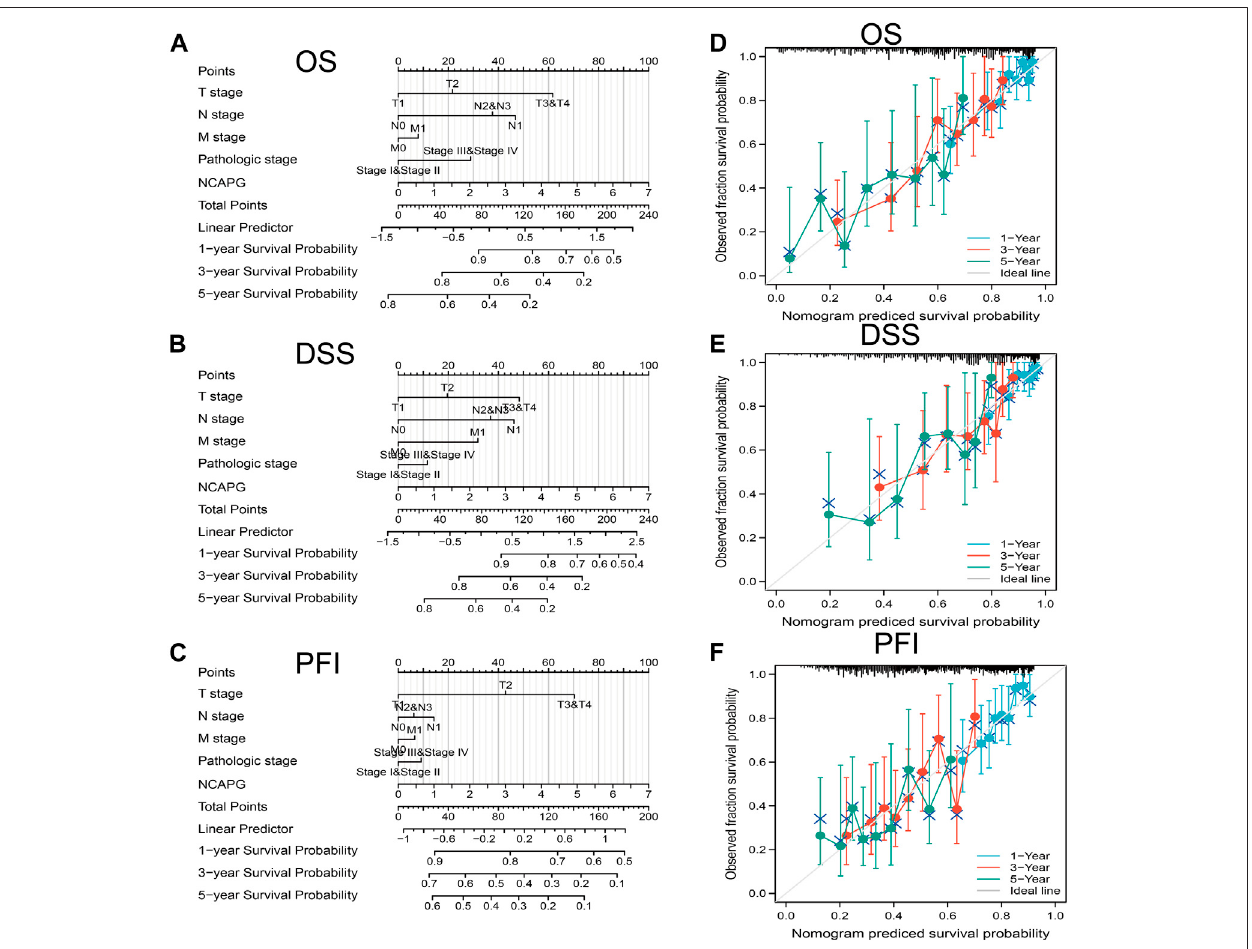
FIGURE 4 | Nomogram for prediction of prognosis in NSCLC patients. Construction and validation of nomograms based on NCAPG expression. Shown are the nomograms constructed to establish NCAPG expression-based risk scoring models for 1-, 3-, and 5-year overall survival (A) , disease-speci fi c survival (B) , and progression-free interval (C) . Calibrationplots validate the ef fi ciency ofnomograms foroverall survival (D) , disease-speci fi csurvival (E) , and progression-free interval (F) . OS, overall survival; FI, progression-free interval; DSS, disease-speci fi c survival. * p < 0.05, ** p < 0.01, *** p < 0.001.